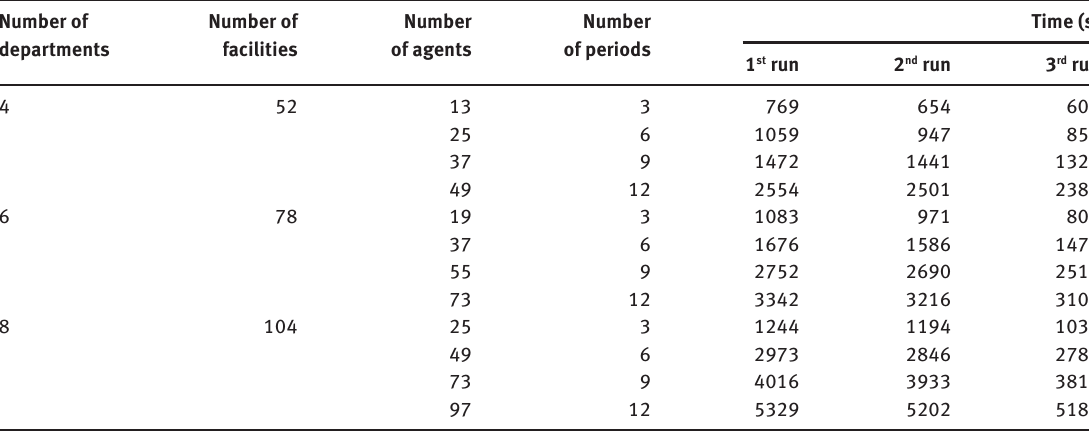
Table 6: Processing Time for Different Instance Sizes of the Adaptive Formulation. Number